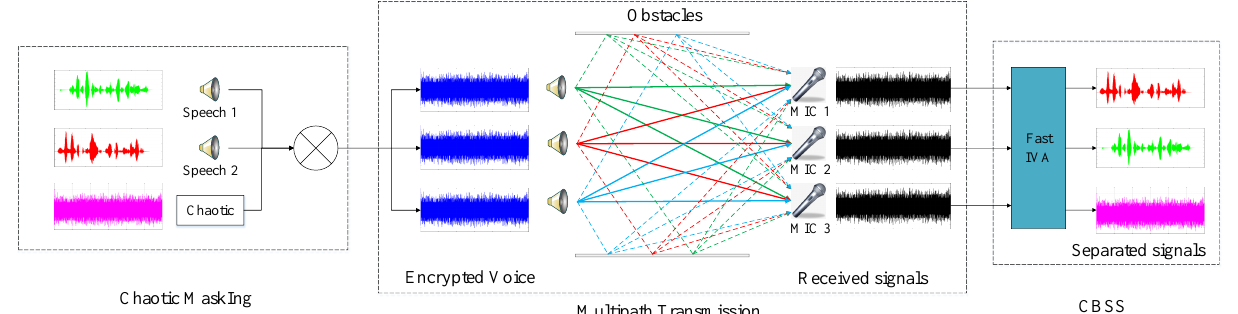
Figure 3. CBSS model for secure transmission of multiple speech